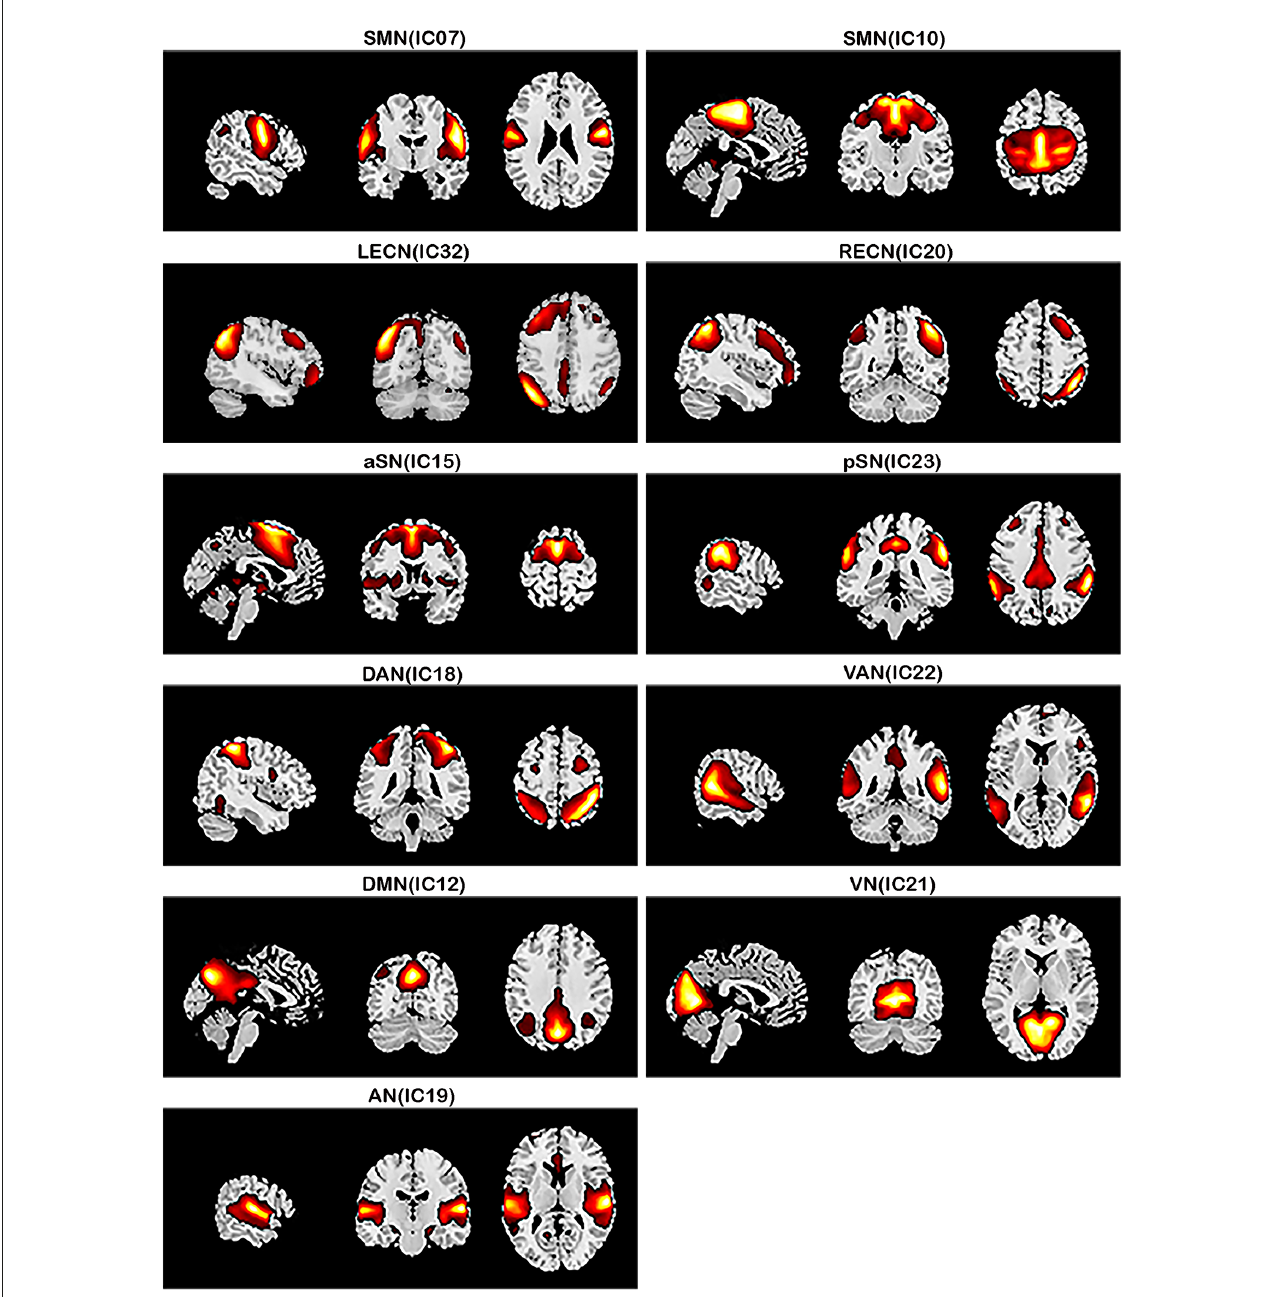
FIGURE1 Large-scale networks including the 11 resting-state networks (RSNs) identified by independent component analysis (one-sample t -test, p < 0.001, FDR corrected). Sensorimotor network, SMN (IC07/IC10); left executive control network, LECN (IC32); right executive control network, RECN (IC20); anterior salience network, aSN (IC15); posterior salience network, pSN (IC23); dorsal attention network, DAN (IC18); ventral attention network, VAN (IC22); default mode network, DMN (IC12); visual network, VN (IC21); auditory network, AN (IC19).